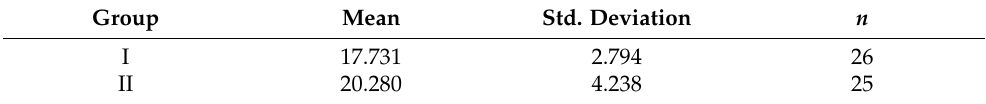
Table 4. Mean results for Perceived Stress Scale for the ANCOVA model for Groups I and II. Group Mean Std. Deviation